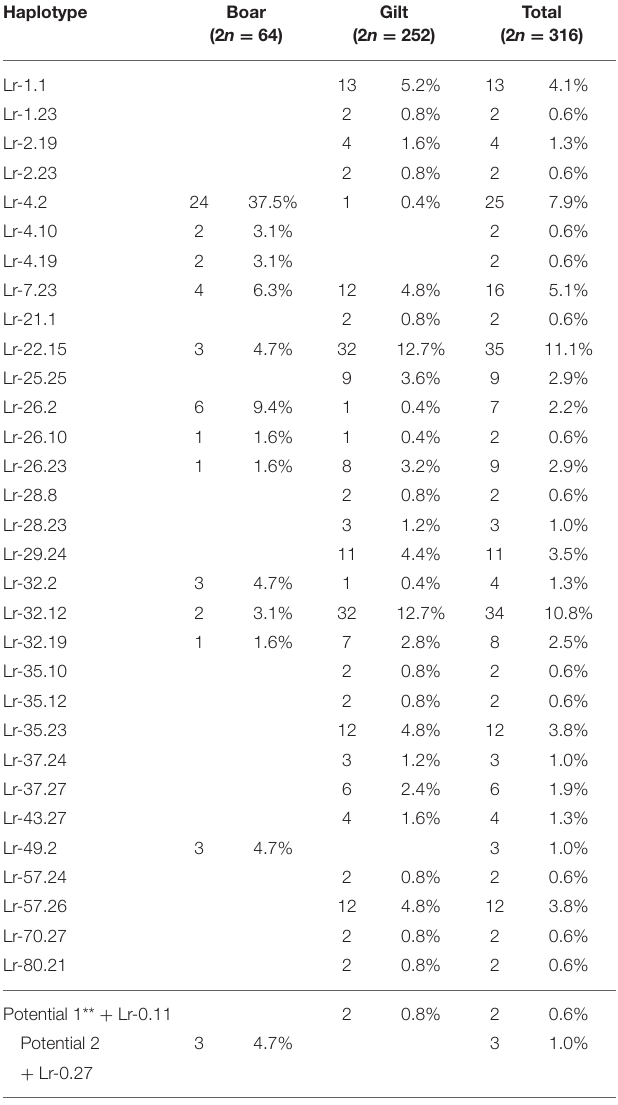
TABLE 5 | Common SLA haplotypes *